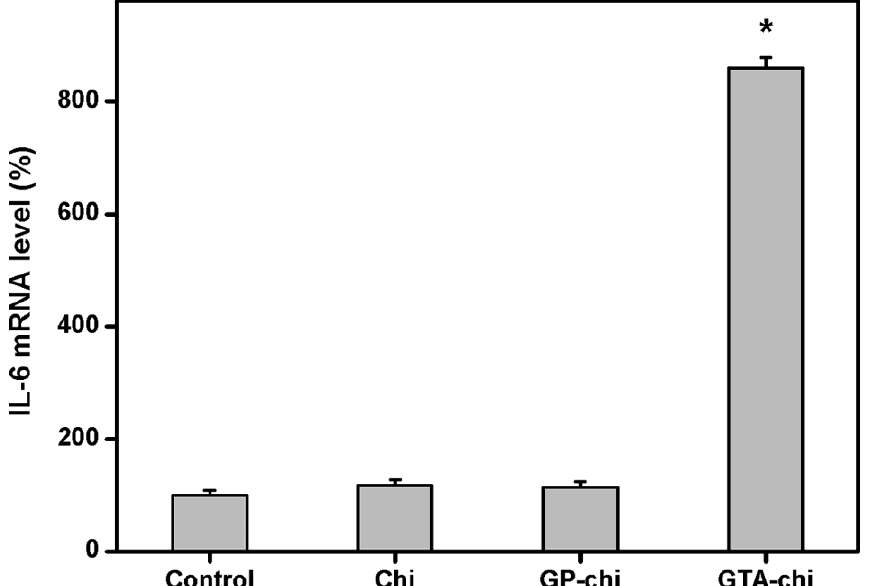
Figure 6. Gene expression of IL-6 in ARPE-19 cells incubated with various chitosan membranes (5 mg) for 3 days, measured by real-time RT-PCR. Normalization was done using GAPDH. Data in the experimental groups are percentages relative to that of control groups (without materials). An asterisk indicates statistically significant differences (* p < 0.05; n = 3) as compared to